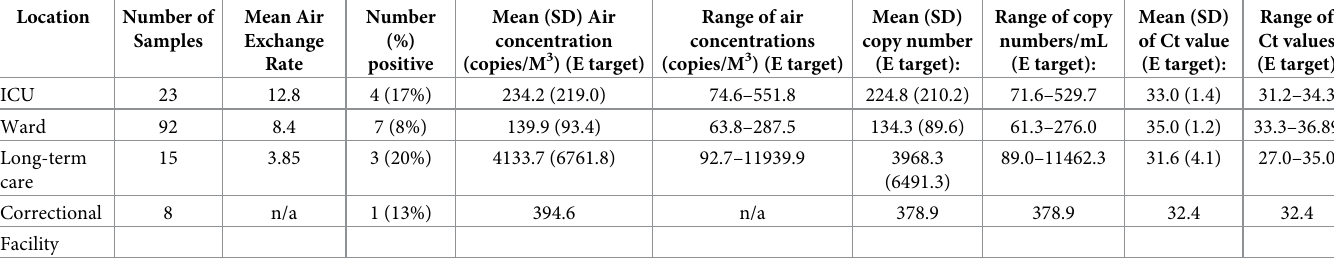
Table 2. Positive SARS-CoV-2 RNA samples by room type, including Ct values for E